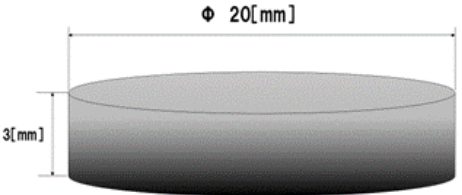
Figure 3. Schematic illustration of samples of FGMs.